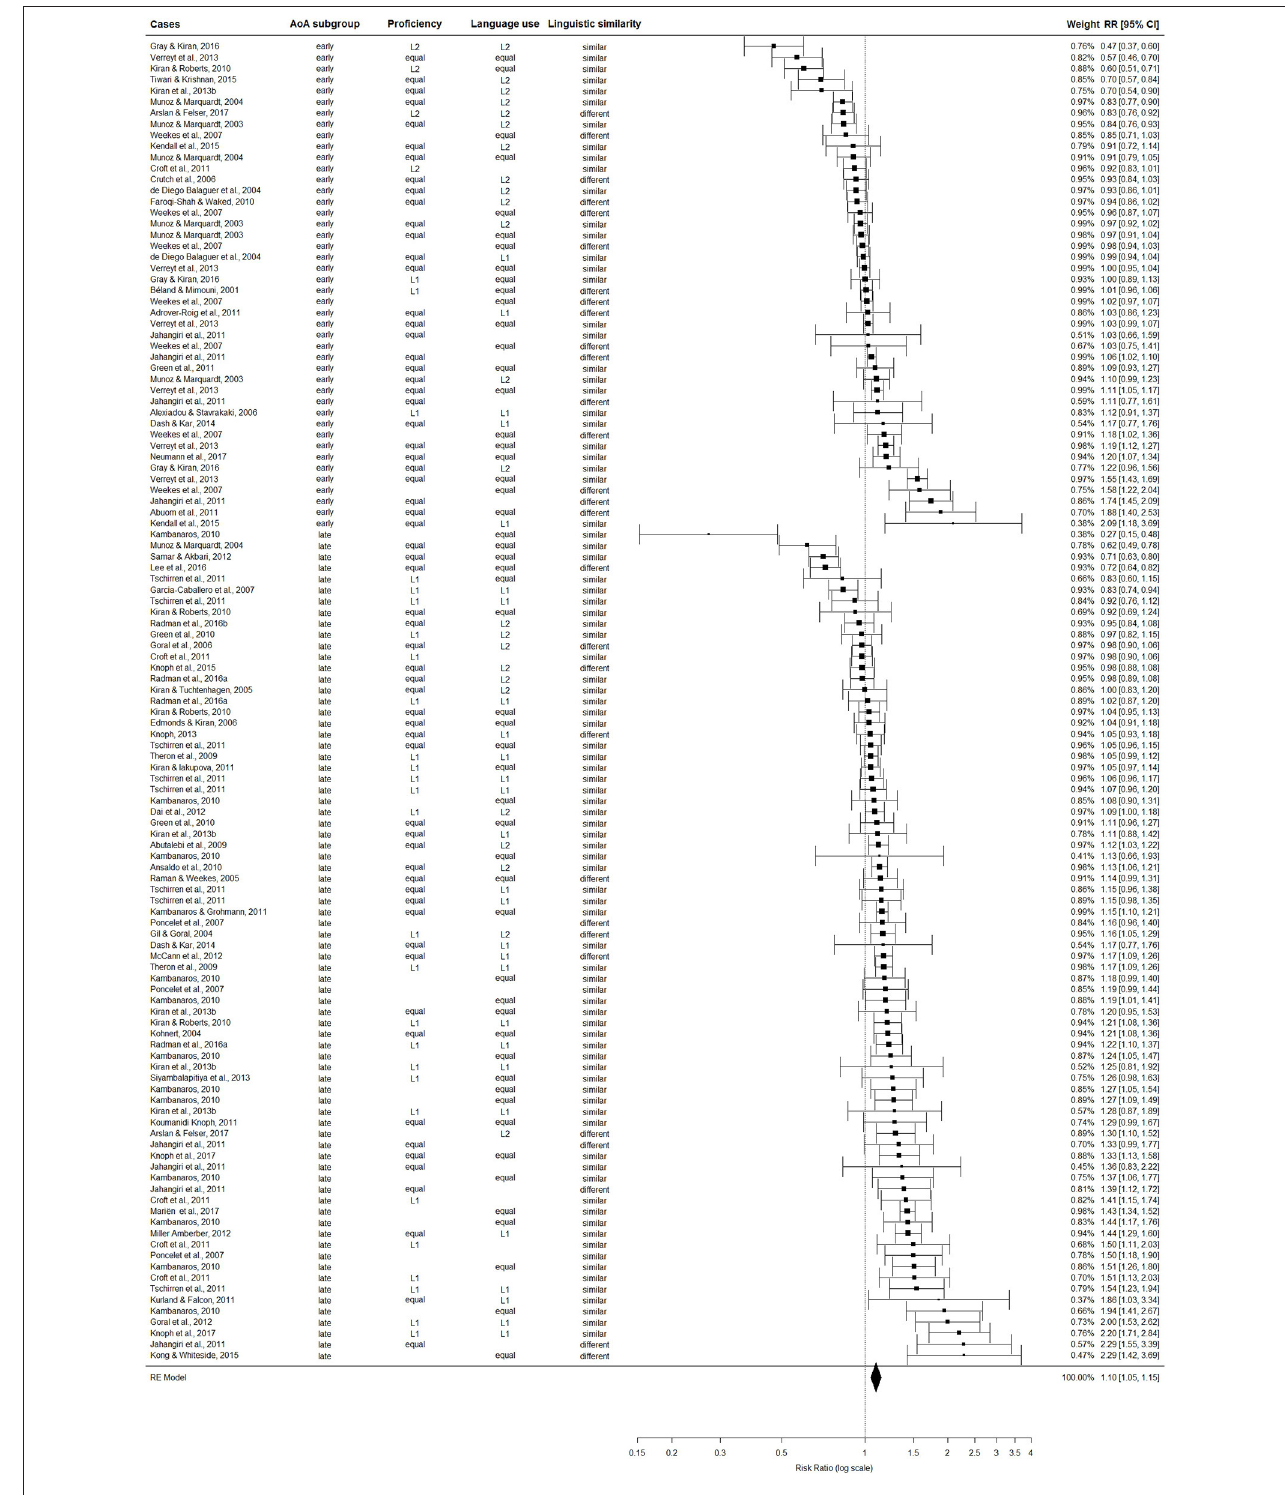
FIGURE 3 | For the whole trimmed sample ( k = 119), the figure displays effect sizes (Risk Ratios) and corresponding 95% confidence intervals (CI) for the comparison between overall language performance in the earlier-acquired (L1) and later-learned (L2) languages. Values larger than one indicate better performance in L1 compared to L2 and values smaller than one indicate worse performance in L1 compared to